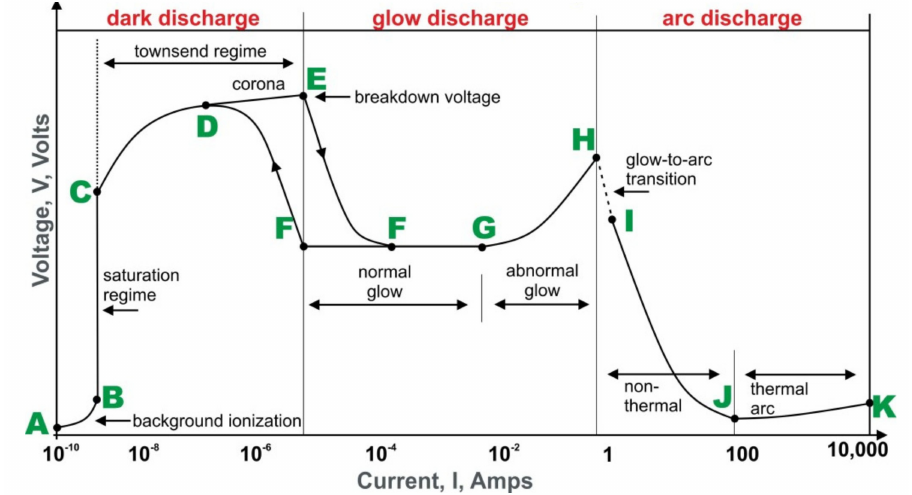
Figure 1. Current-voltage (I-V) characteristics of direct current (DC) electrical